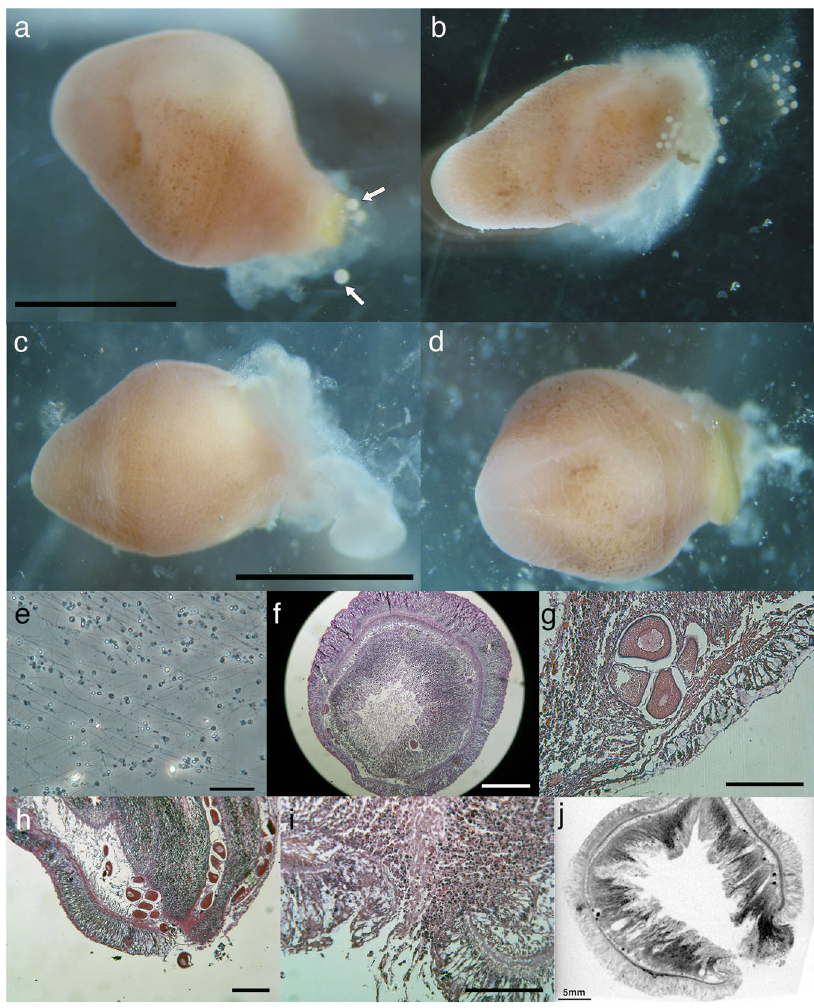
Fig. 4 Spawning of Xenoturbella bocki . Female ( a , b ) and male animals ( c , d ) spawn gametes together with white mucus from their posterior ends. Dorsal view with the anterior to the left. White arrows: eggs. e Sperm present in the mucus released by the male specimen is shown in ( d ). f Section of a female specimen. The epidermis is thin, and the subepidermal membrane complex (SMC) are scarce at the bottom left of the picture. g Posterior end of a female specimen where the epidermis is thin and SMC are scarce. h A rupture formed at the posterior end of a female. i A close-up of a rupture formed at the posterior end of a female. j Coronal microCT section of an animal with a rupture that connects to the gut cavity. Scale bars: a , c , j : 5 mm; e : 10 μ m; f : 500 μ m; g – i : 200 μ m. Table 1 Site of rupture after spawning induction in Xenoturbella bocki